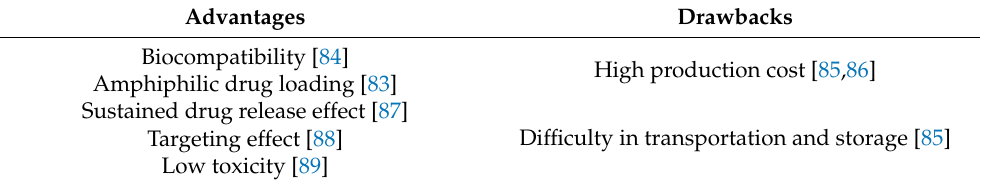
Table 2. Advantages and drawbacks of liposomes as carriers in regenerative medicine. Advantages